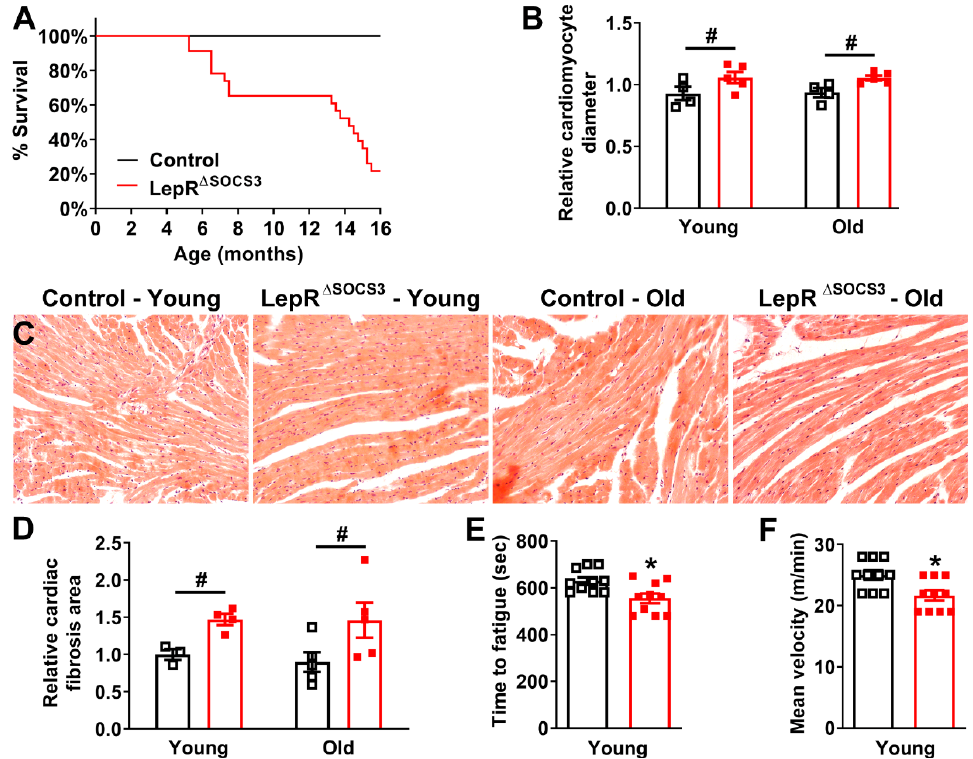
Figure 4. Cardiac abnormalities and decreased survival rate in aging LepR ∆ SOCS3 mice. ( A ) Survival curve of control (black square; n = 27) and LepR ∆ SOCS3 (red square; n = 23) mice. ( B ) Relative cardiomyocyte transverse diameter in young adult (3-month-old; n = 4–5/group) and middle-aged (15-month-old; n = 4–5/group) mice. ( C ) Representative transverse heart sections stained with hematoxylin and eosin of young adult or middle-aged control and LepR ∆ SOCS3 mice. ( D ) Relative cardiac collagen area in young adult ( n = 3–4/group) and middle-aged ( n = 5/group) mice. ( E , F ) Time required until fatigue and mean velocity during an incremental treadmill maximal running test in young adult control ( n = 10) and LepR ∆ SOCS3 ( n = 10) mice. Mean ± SEM. * p < 0.05 control vs. LepR ∆ SOCS3 ( t -test). # p < 0.05 SOCS3 ablation effect (two-way ANOVA).